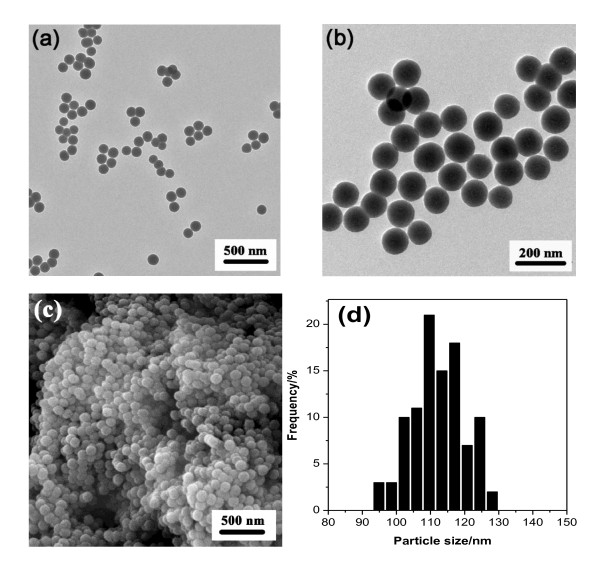
TEM (a, b), SEM (c), and particle size distribution (d) of Co-SiO2.